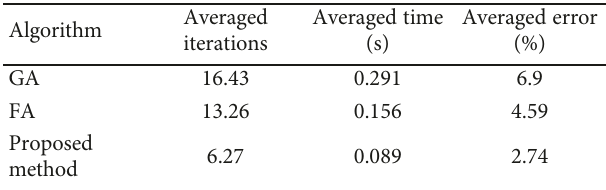
Table 13: Comparison of evaluation results for the GA, FA, and the proposed